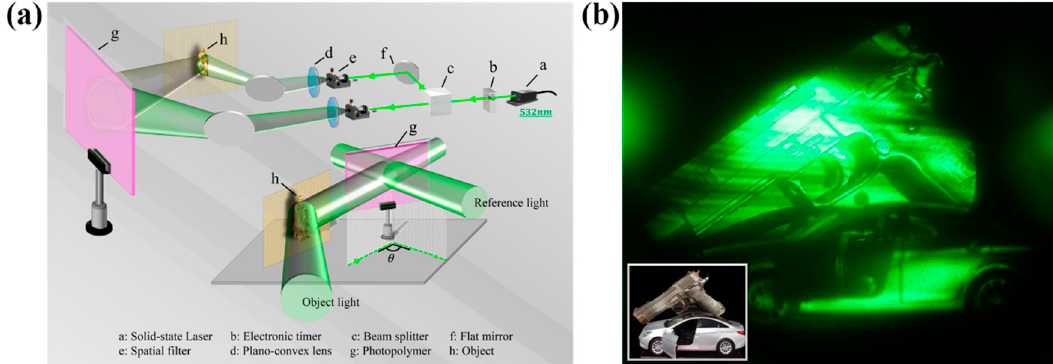
Figure 8. ( a ) Schematic diagram of transmission holographic device; ( b ) reproduction image of transmission hologram using green light.